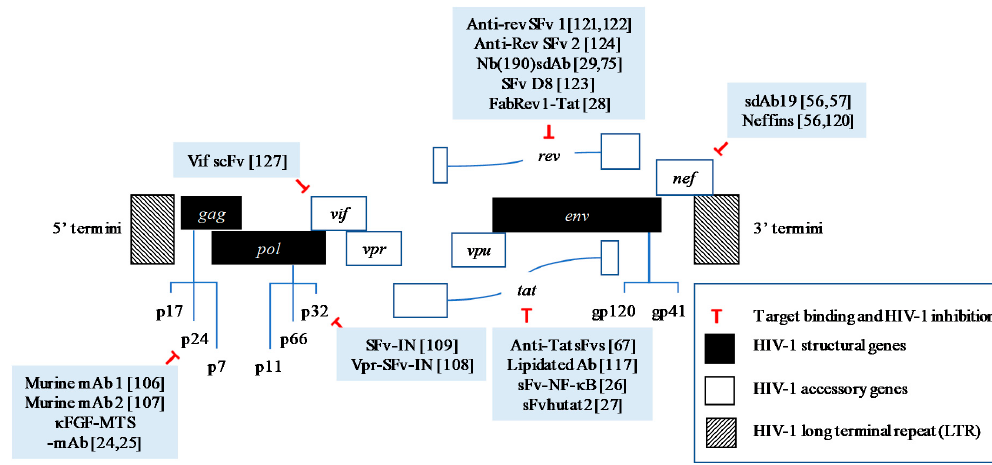
Figure 2. HIV-1 genes and their encoded proteins targeted by full-length antibodies or intracellular antibody fragments with promising therapeutic activities.